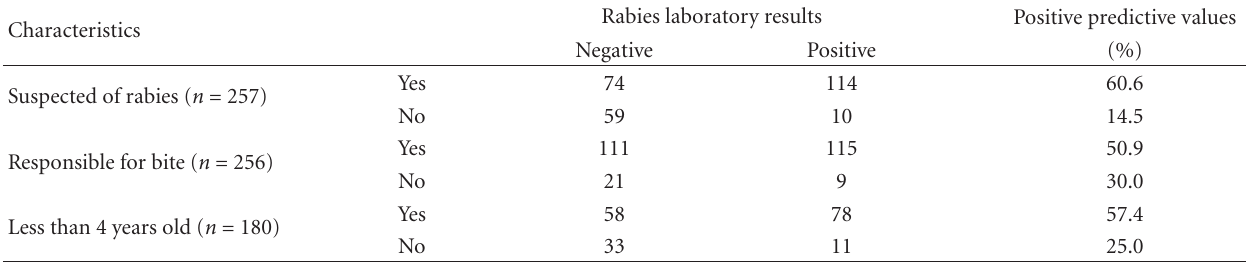
Table 2: Positive predictive values according to some characteristics of dogs tested for rabies (reported alone), Madagascar, 2006–2010. Characteristics